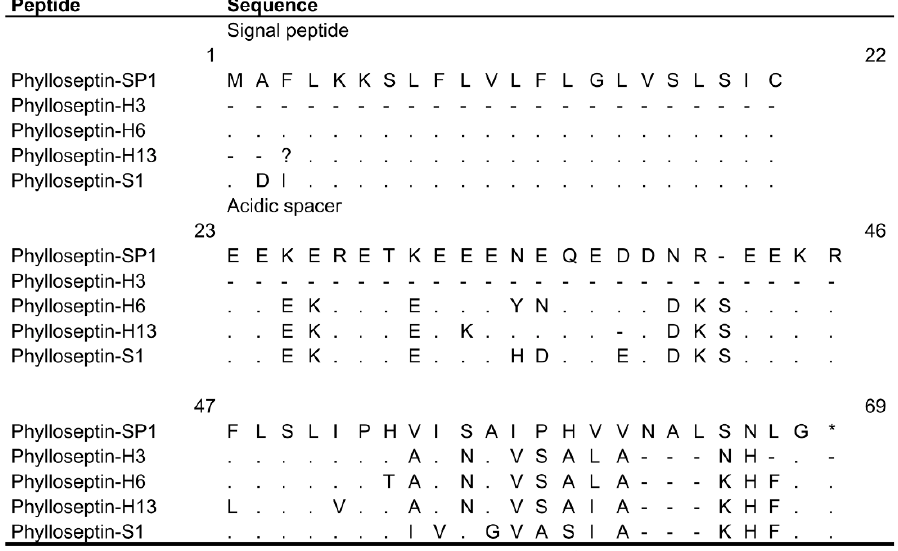
Figure 3. Comparison of amino acid sequence similarity of phylloseptins. PLS-SP1 of A. spurrelli , PLS-H3, PLS-H6, and PLS-H13 of Phyllomedusa hypochondrialis , and PLS-S1 of P. sauvagii (accession